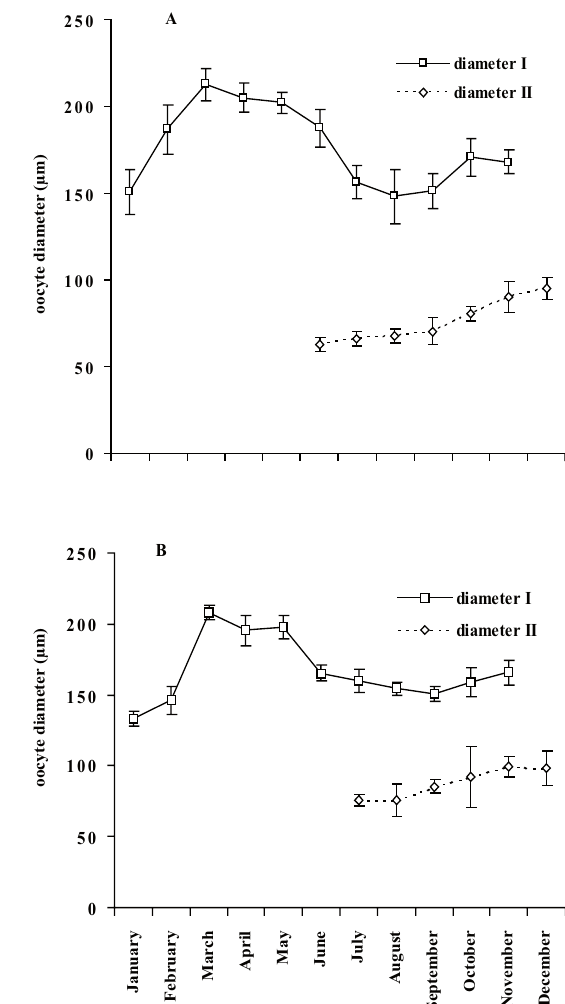
F IG . 4. – Evolution of oocyte size from January to December 2005. Each data point represents mean ± standard deviation. Diameter I corresponds to the diameter of oocytes of females bearing large oocytes while diameter II corresponds to the diameter of oocytes of females bearing small oocytes when two groups of females can be identified. A: Pointe Pescade, B: